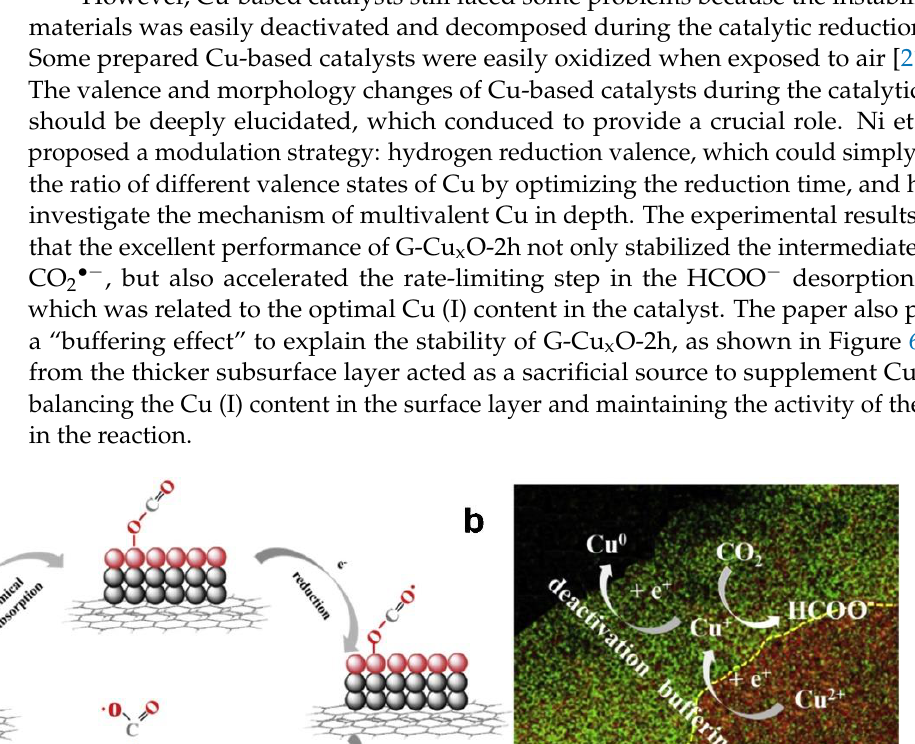
Figure 7. Proposed mechanisms for CO 2 reduction to CO on polycrystalline Au and oxide-derived Au. Reprinted from Ref. [112], copyright (2012), with permission from the American Chemical So- ciety. Gao et al. synthesized a Pd nanoparticle electrode and efficiently catalyzed the reduction of CO 2 to CO. They found that Pd nanoparticle size exhibited significant size dependence in the range of 2.4 – 10.3 nm [113]. With the Pb nanopar- ticle size changes from 10.3 to 3.7 nm, the Faraday conversion efficiency of CO generation at − 0.89 V increased from 5.8% to 91.2%, while the current density of CO generation was enhanced 18.4 times (Figure 8). The relationship be-